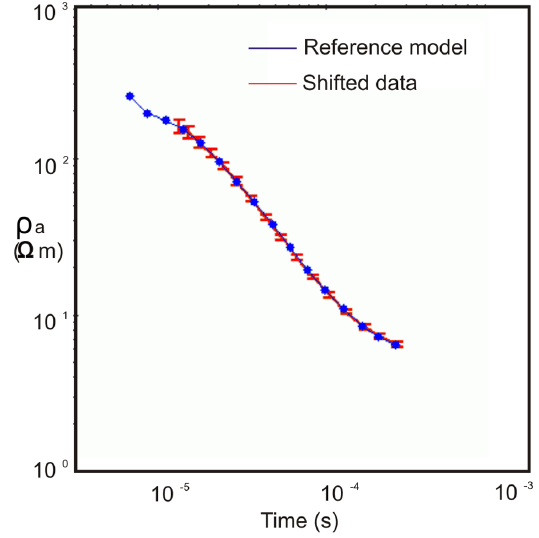
Figure 9. Comparison between the reference response (blue curve) and the shifted (red curve) data for the ultra high (UH) segment after calibration for a 100 × 100 m loop.